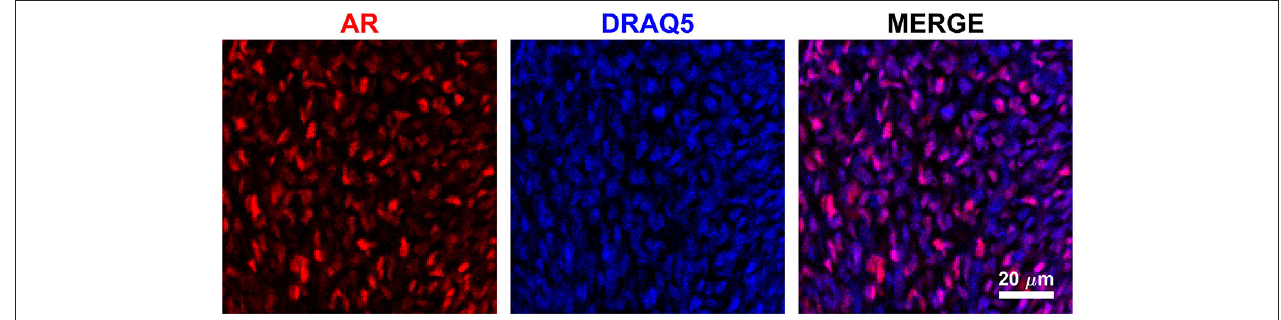
FIGURE 2 | Image of gubernacular mesenchymal core in culture shows variable AR expression among cells, and predominantly nuclear localization of the receptor (red = AR, blue = DRAQ5 nuclear stain). Image shown of E17 LE/wt, localization and staining patter qualitatively conserved at E19 and E21 in both LE/wt and LE/orl.